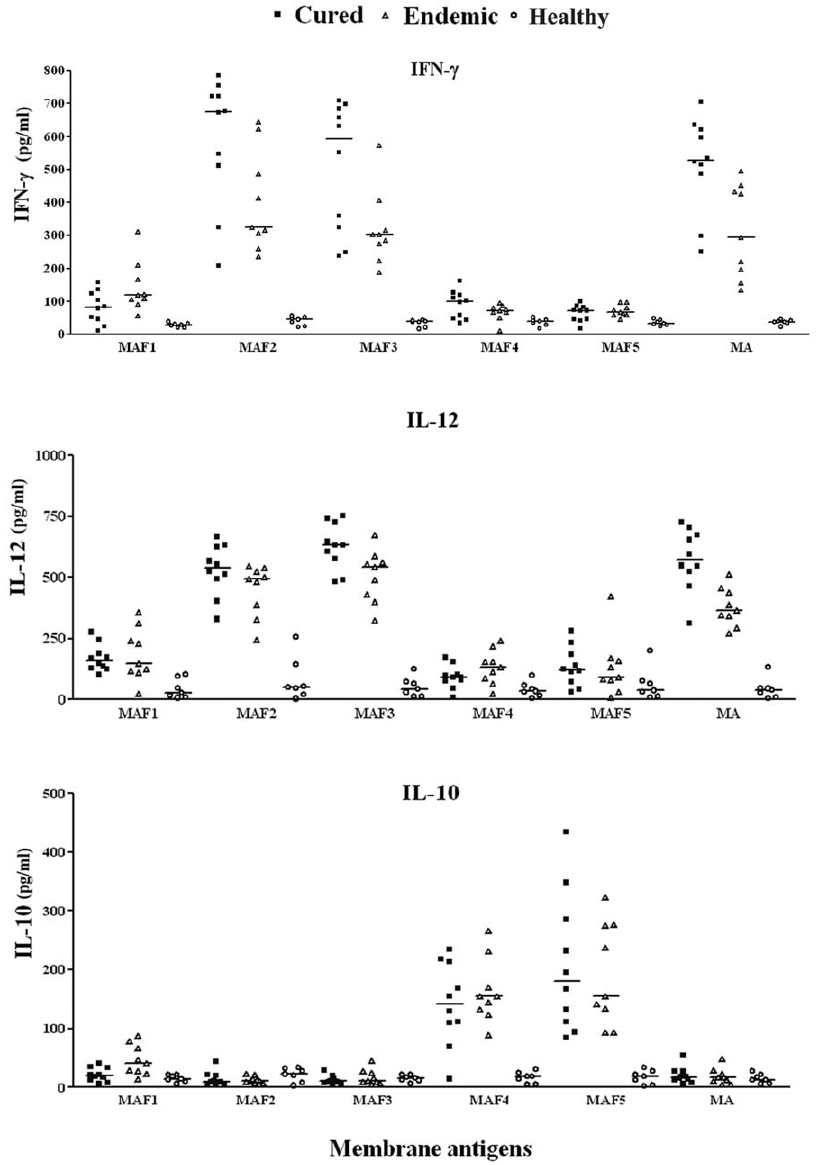
Figure 5. Th1/Th2 cytokine levels (IFN- c , IL-12 p 40, IL-10) of PBMCs from cured VL patients (full course of treatment with Amphotericin B) ( & ), endemic contacts ( m ) and healthy (o) individuals against membrane antigenic fractions used at a concentration of 10 m g/ml (1 m g/well). The results are presented in the graph as for individual human sample along with horizontal bar representing the median.